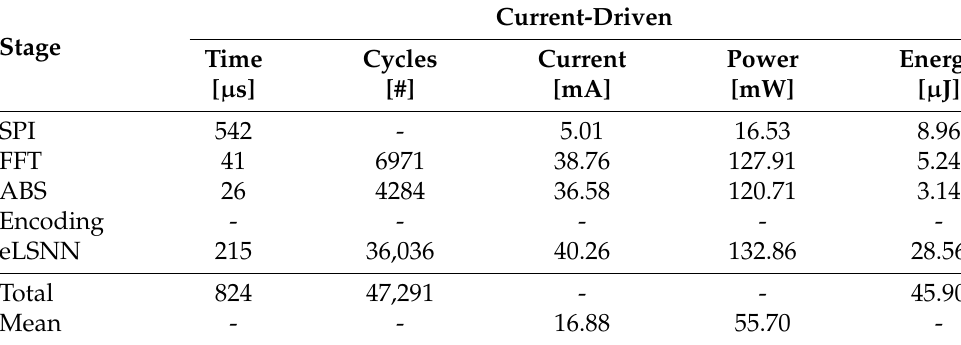
Table 3. Power report of the SHM application featuring the best eLSNNs tested. The SPI master transfers data with a serial clock of 8 MHz. The SPI stage includes: (i) The SPI data transfer, (ii) the time required by the system-on-chip to reconfigure the clock to 168 MHz when it wakes-up from SLEEP mode and (iii) the conversion of sensor data from raw integers to